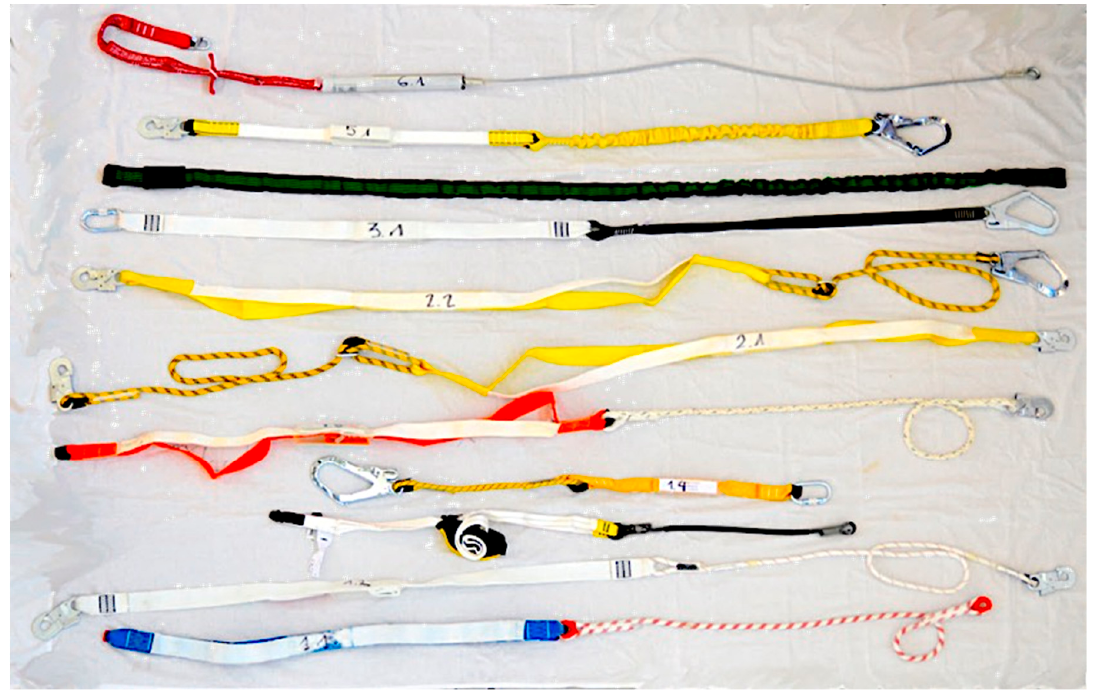
Figure 7. Samples after dynamic performance test.